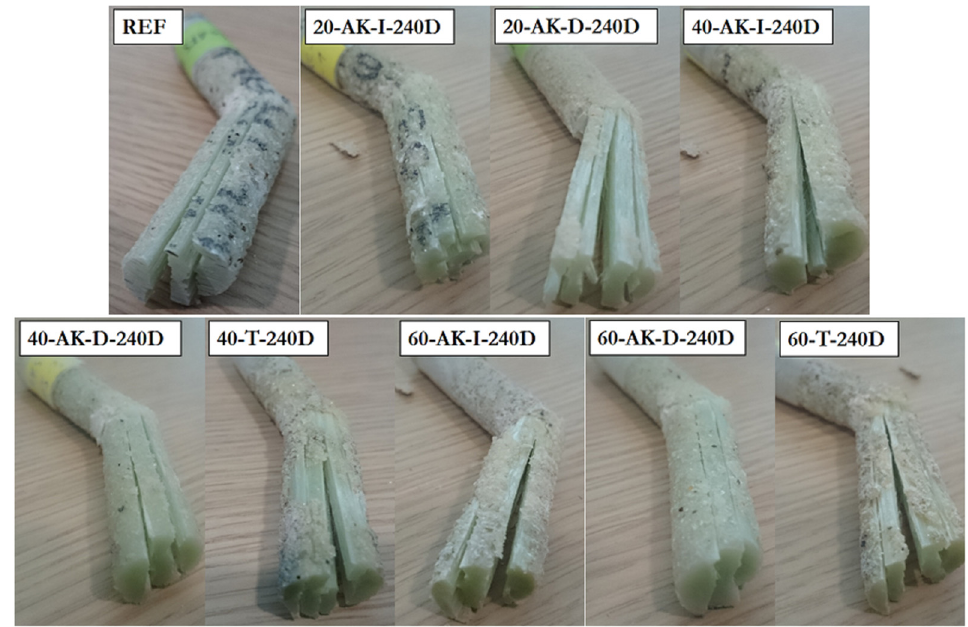
Figure 16. Failure modes observed after short-beam tests on reference and aged GFRP rebars. ILSS values determined on the various specimens are referenced in Table 8 and sum- marized in Figure 17.